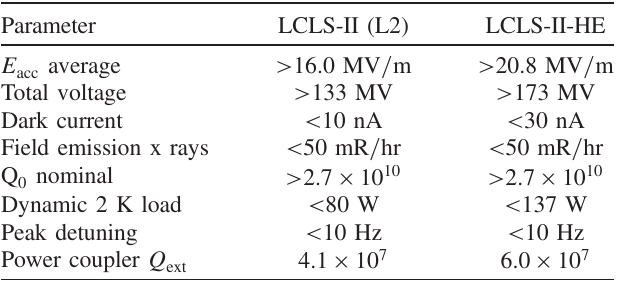
TABLE I. Comparison of operating parameters for L2 (original superconducting linac) and HE (high energy upgrade) SRF cryomodules.